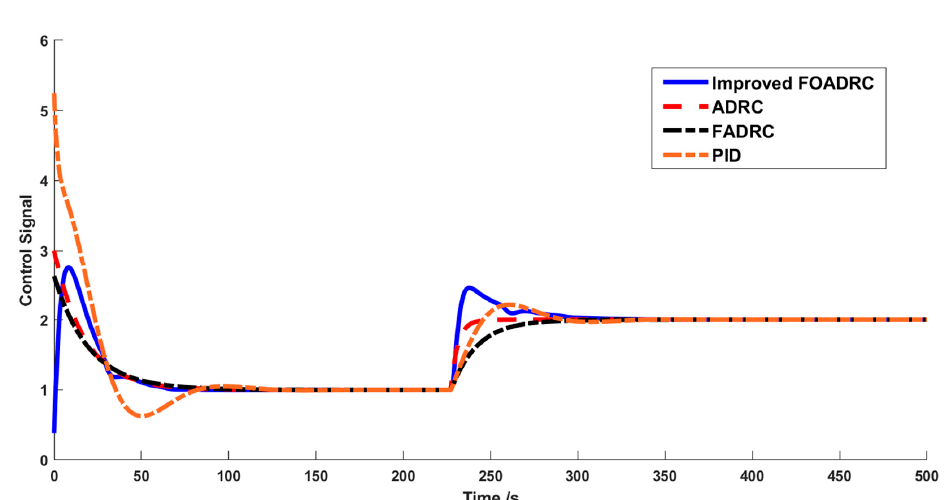
Figure 10. Control Figure 10. Control signals.